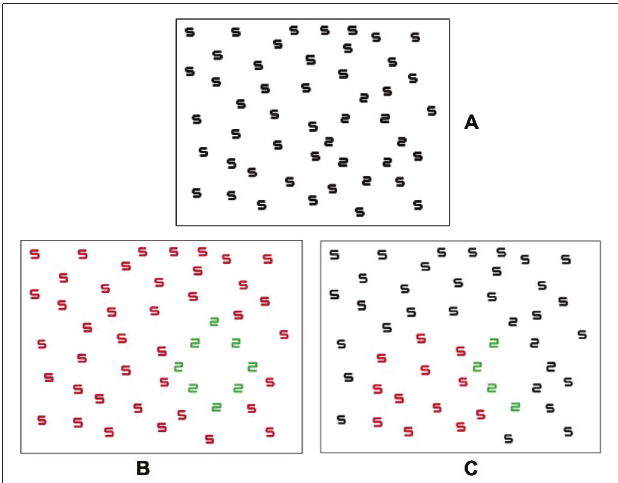
FIGURE 1 | An example stimulus (A) as presented (in black font), (B) a schematic assuming presentation in color, and (C) a partially colored version in line with the phenomenological reports of projector synesthetes . Note that stimuli were never presented in color during the experiment.